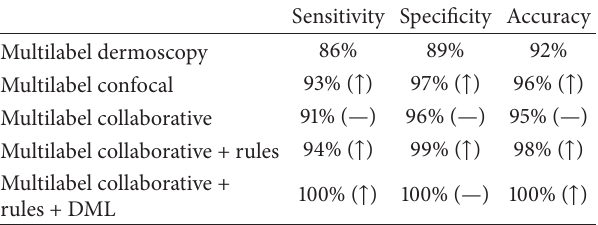
Table 2: Sensitivity, specificity, and accuracy results obtained in multilabel classification using dermoscopy data, confocal data, and both types of data with a collaborative system and using the different DERMA modules. Each result shows the 𝑡 -test comparison between the result obtained on this DERMA configuration in comparison with the previous one using 95% of confidence level. This is presented with an ( ↑ ) if it is significantly better and (—) if there is no significant